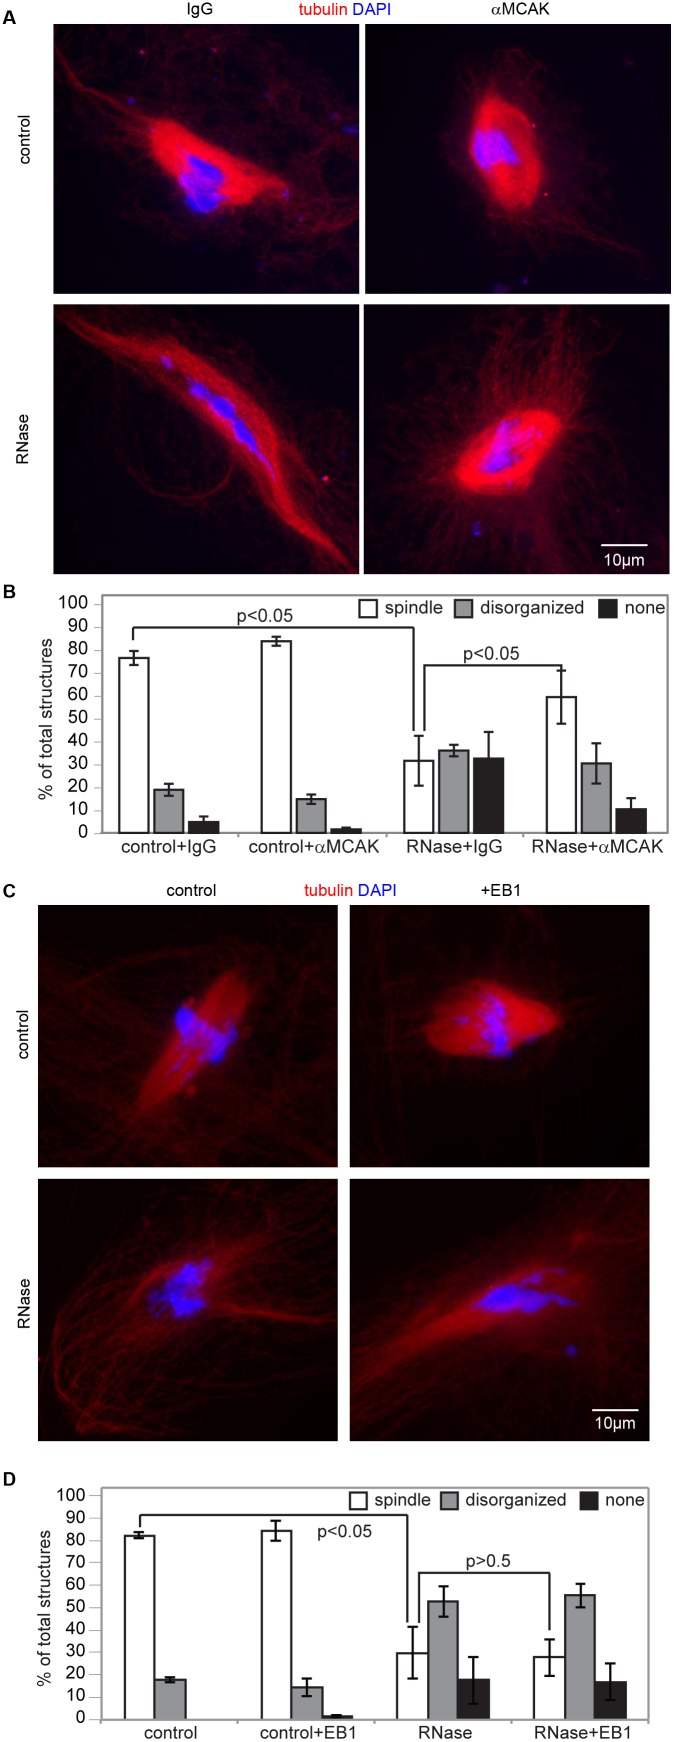
Spindle defects in the absence of RNA arise from aberrant regulation of MCAK.
A) Spindles formed in extracts (+/− RNase) in the presence of nonspecific or αMCAK antibodies. An example of a rare spindle in control RNase-treated extracts is shown. All spindle reactions contained CyclinB Δ90. Images shown are projections. B) Spindle assembly efficiency in extracts shown in (A). “None” indicates that no microtubule structures formed around nuclei. (n = 4 extracts, >100 nuclei per extract, p<0.05 by paired t-test). Error bars represent SEM. C) Examples of spindle assembly in control and RNase-treated extracts in the presence or absence of 750 nM EB1-GFP. Disorganized structures formed in RNase-treated extracts are shown. Images shown are projections. D) Spindle assembly efficiency in extracts shown in (C). (n = 3 extracts, >100 nuclei per extract p<0.05 for control vs RNase-treated p>0.5 for RNase +/− EB1 by paired t-test). Error bars represent SEM.